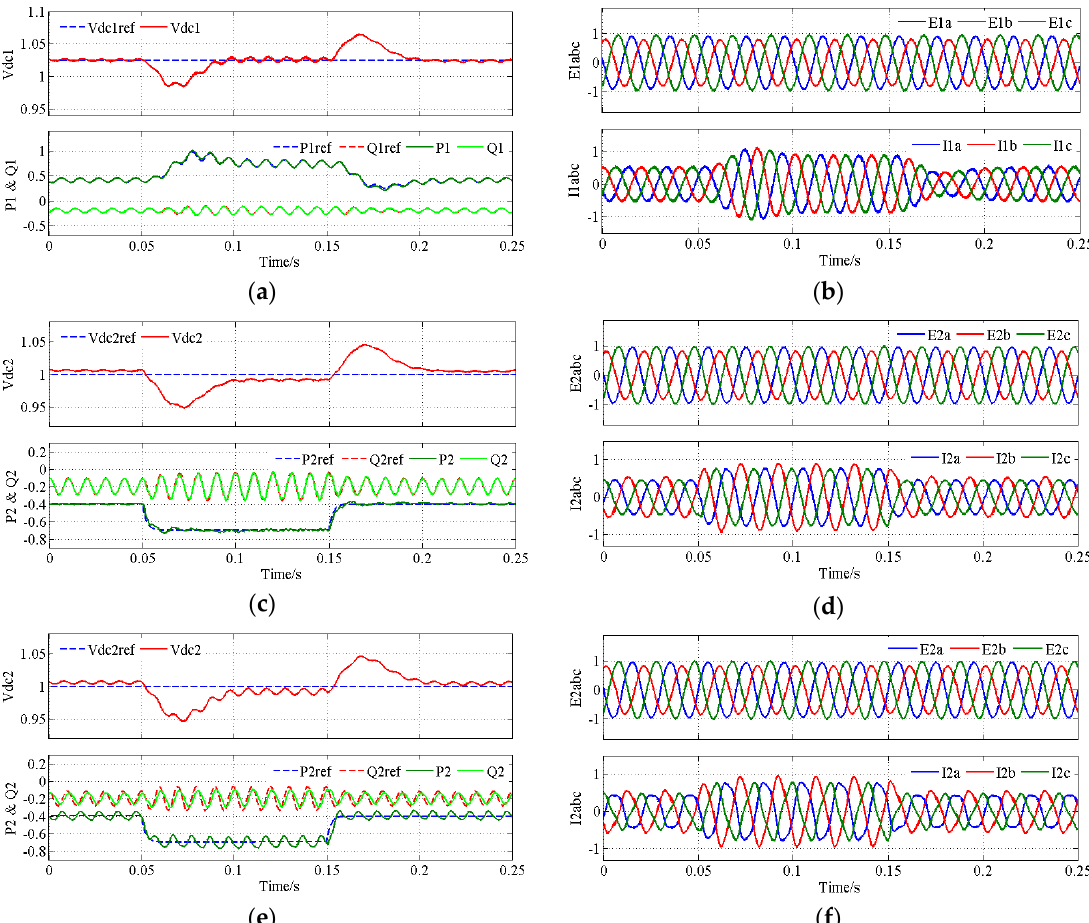
Figure 6. System response to active power step changes under grid voltage unbalance. ( a ) dc bus voltage, active and reactive power for CS1 by IRSMC DPC controller; ( b ) grid voltage and ac current for CS1 by IRSMC DPC controller; ( c ) dc bus voltage, active and reactive power for CS2 by IRSMC DPC controller; ( d ) grid voltage and ac current for CS2 by IRSMC DPC controller; ( e ) dc bus voltage, active and reactive power for CS2 by ISMC DPC controller; ( f ) grid voltage and ac current for CS2 by ISMC DPC controller.